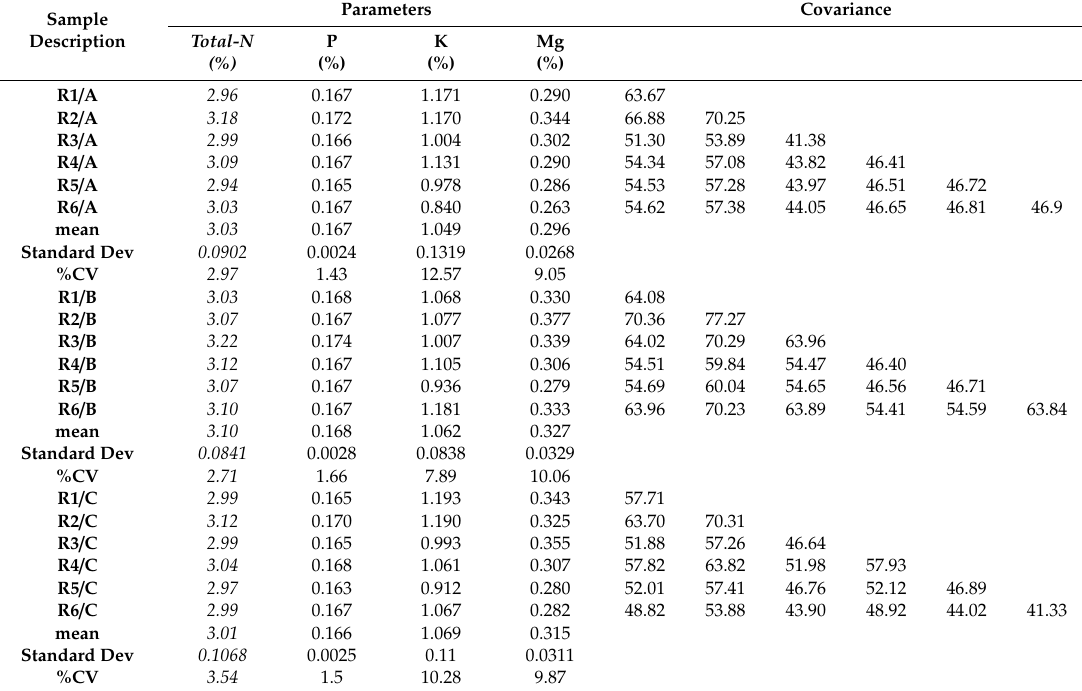
Table 6. Leaf sampling results.